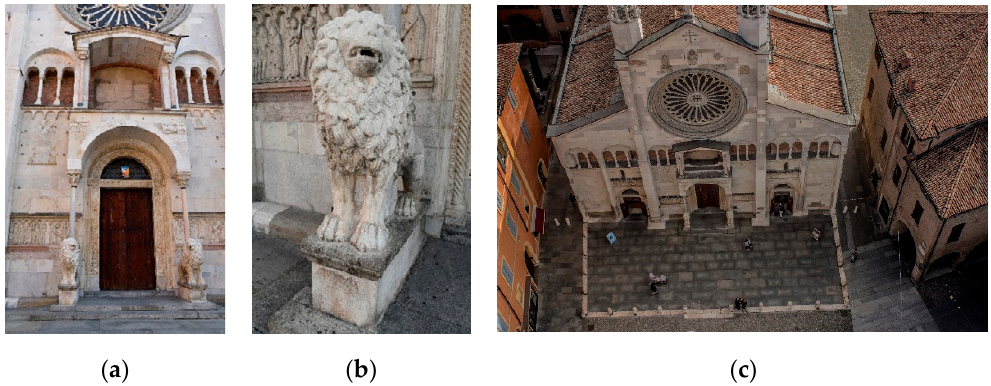
Figure 5. Some examples of the Modena Cathedral dataset: ( a ) and ( b ) terrestrial images; ( c ) UAV-based image.